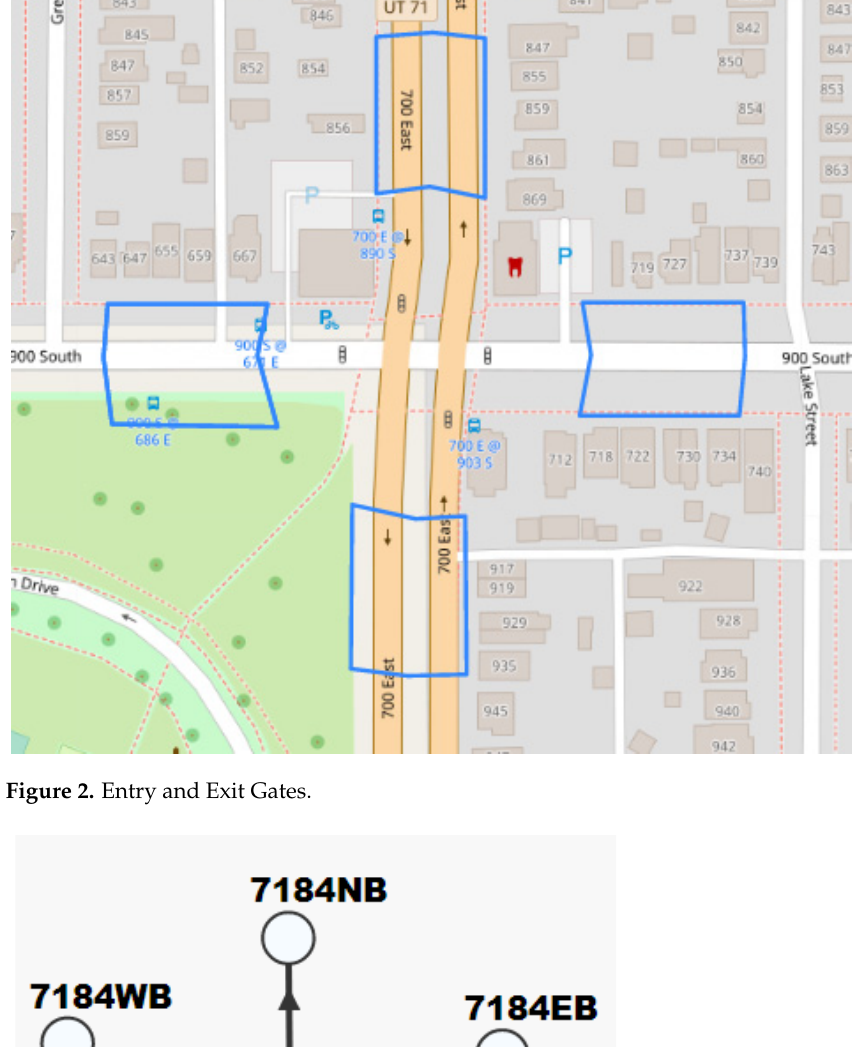
Figure 2. Entry and Exit Gates.